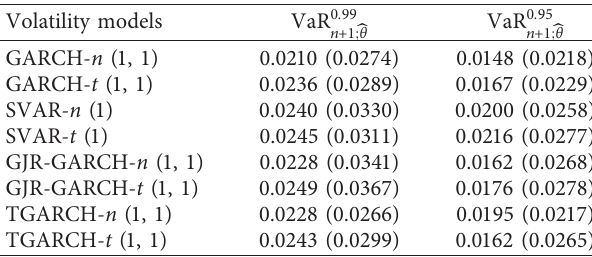
Table 1: The VaR forecast (and improvement) for Generalized ARCH and SVAR models and some extensions of volatility